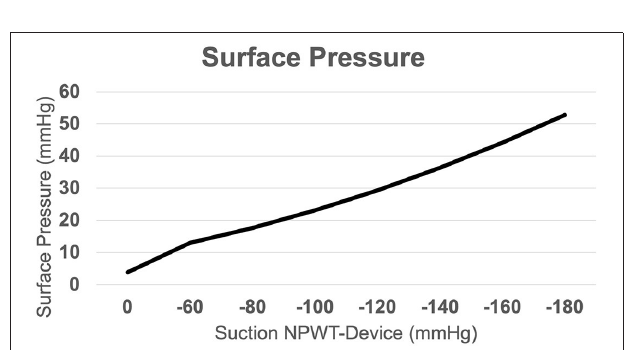
FIGURE 5 | Surface Pressure. Resulting surface pressure due to applied suction via the NPWT-device, indicating an almost linear correlation between applied suction and positive pressure acting on the skin surface.